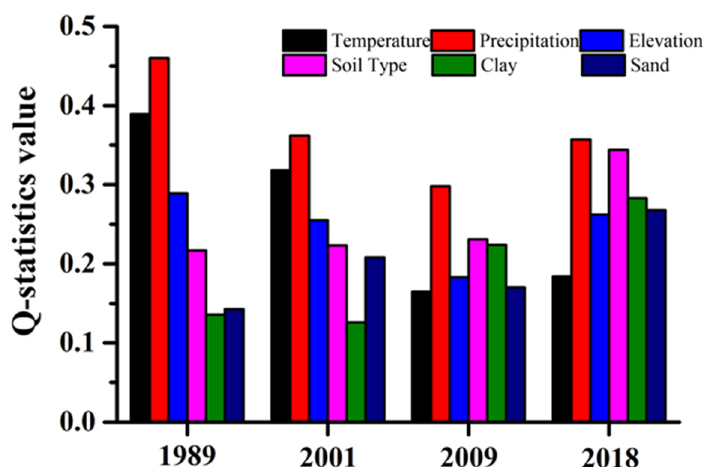
Figure 6. Q-statistic values in the geodetector analysis of the predictor importance for soil organic matter (SOC) in Aohan Banner. (All variables in Figure 5 show strongly significant effects at p < 0.01).